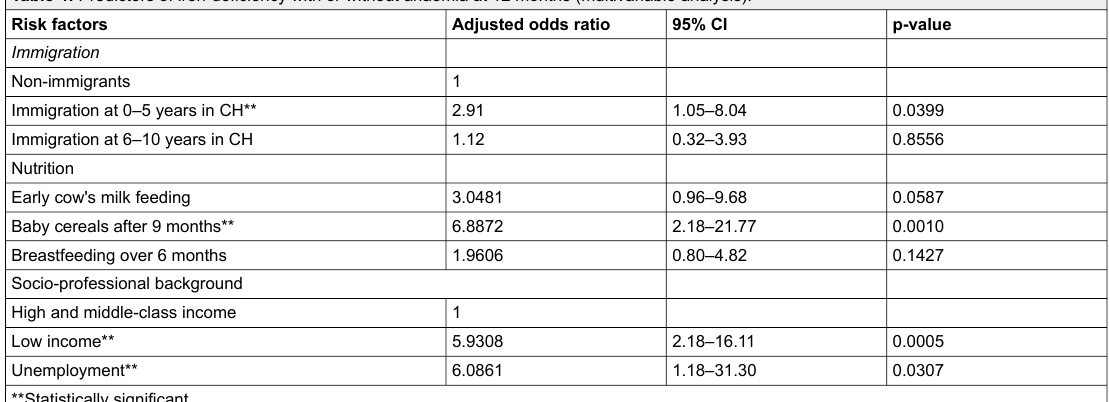
Table 4: Predictors of iron-deficiency with or without anaemia at 12 months (multivariable analysis). Risk